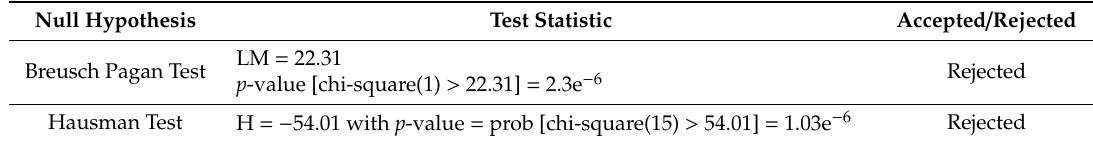
Table 2. Panel Diagnostic Tests for Lerner Estimates. Panel Period: 1994–2016.